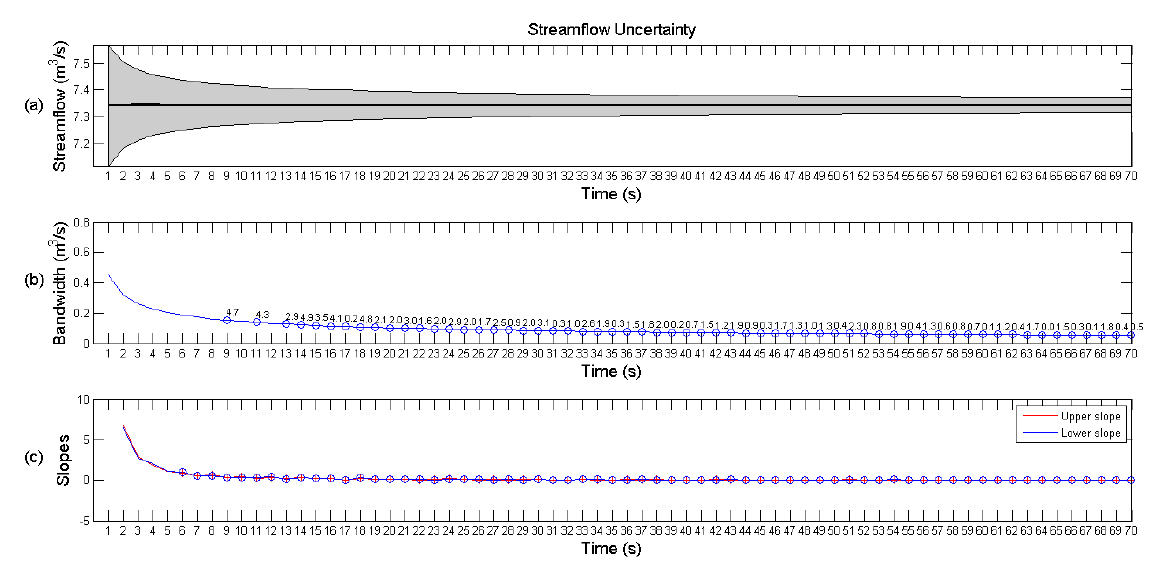
Figure 5. Representation of flow measurement results, ( a ) uncertainty bands, ( b ) bandwidths with indicators for the criterion of percent variation less than 5%, ( c ) upper and low slopes with indicators for the criterion of slopes less than 1%.